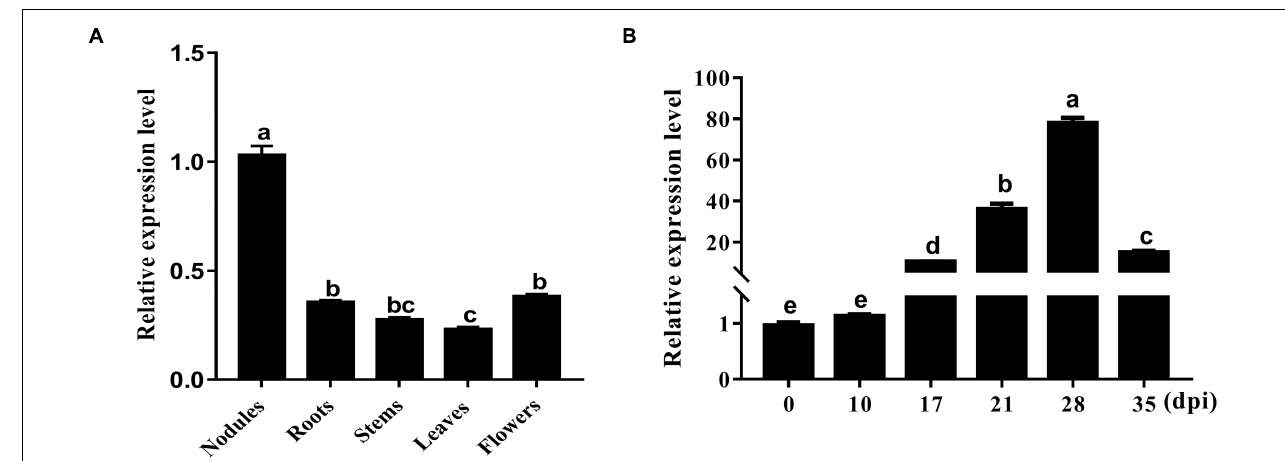
FIGURE 1 | Expression pattern of GmHSP17.1 in different organs of soybean. (A) Transcript accumulation of GmHSP17.1 in soybean nodules at 28 dpi, roots, stems, leaves, and flowers. (B) The expression profiles of GmHSP17.1 in rhizobia-inoculated roots (0 dpi) and nodules (10, 17, 28, and 35 dpi). The relative expression value was normalized based on the expression of GmActin11 ( Glyma.18g290800 ) used as reference gene. Lowercase letters represent statistically significant differences ( p < 0.05) according to Tukey’s HSD test. All experiments were repeated at least three times. Dpi, days post inoculation.